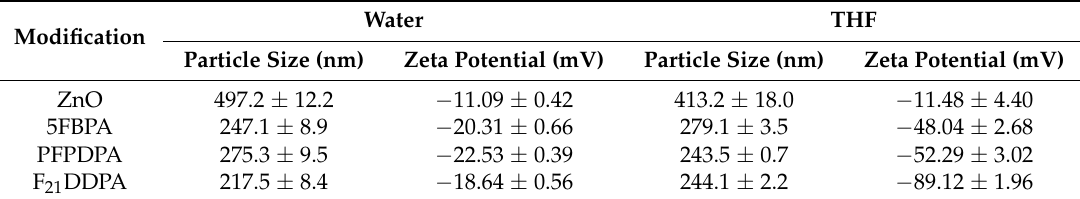
Table 3. Particle size and zeta potential values of the hydrodynamic diameters of ZnO and surface modified nanoparticles obtained using dynamic light scattering